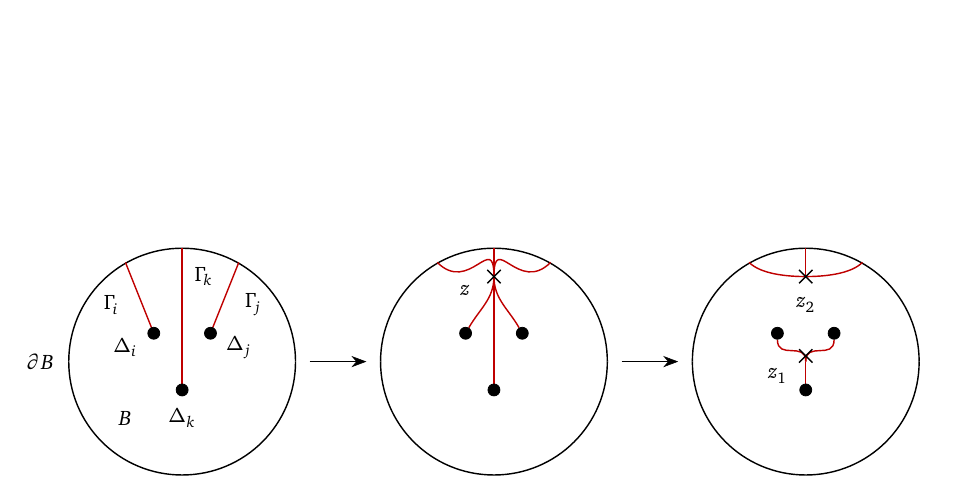
Figure 3: Picture of two homologous relative 2-cycles T (cid:48) ( γ , z (cid:48) } ) . Sliding the thimbles vertically along the discriminant component ∆ T (cid:48) , { C Γ (cid:48) k i establishes the homotopy. As a consequence they project to the same thimble T